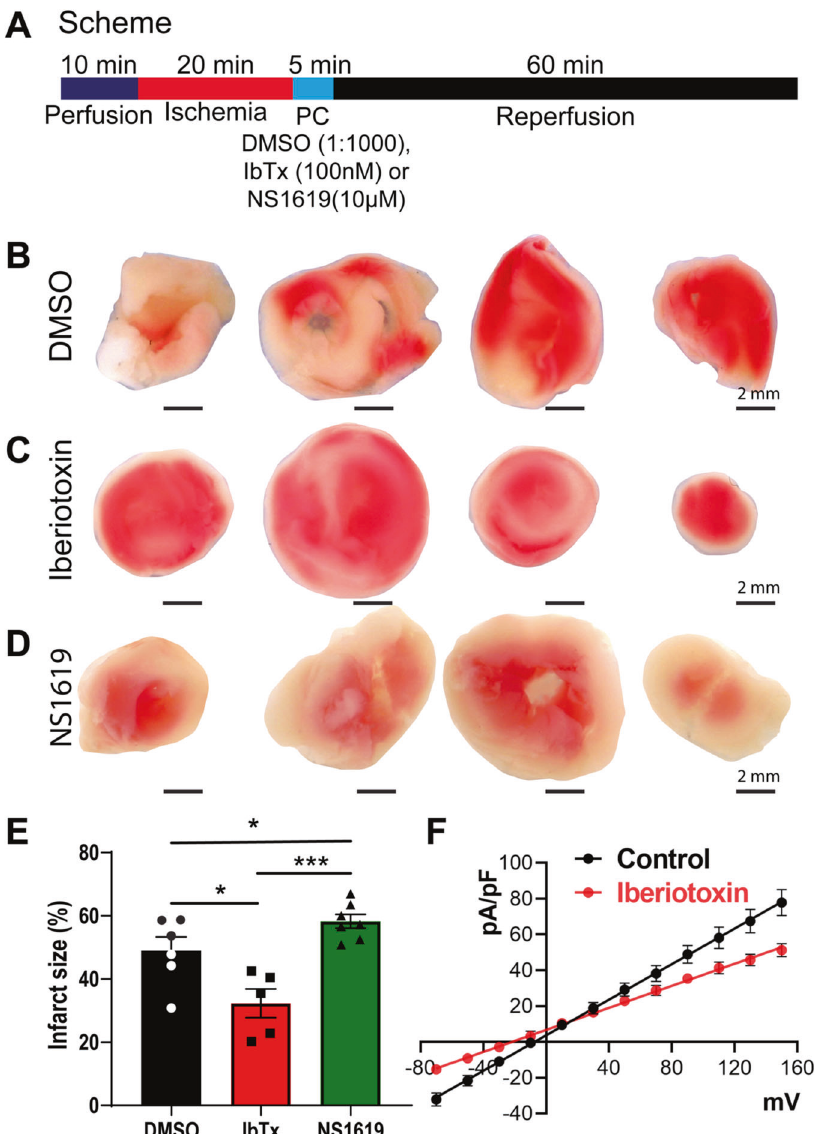
60 min of reperfusion. Hearts post-conditioned with C and E iberiotoxin exhibited signi fi cantly less infarction (white) as compared to the B and E DMSO control. In hearts post-conditioned with NS1619 displayed signi fi cantly higher infarction compared to DMSO control and